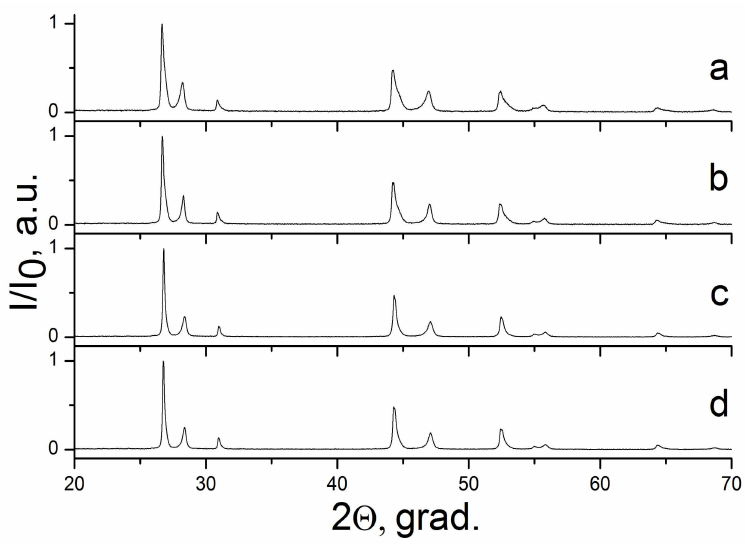
Figure 9. X-ray diffraction patterns of samples in the CaF 2 –SrF 2 (1:1) system synthesized at 300 ◦ C, ratios of M(NO 3 ) 2 :NaF:NaNO 3 (M = Ca + Sr) starting materials: ( a ) 22:33:45 (sample 17); ( b ) 8:12:80 (sample 18); ( c ) 17:50:33 (sample 19); ( d ) 7:21:72 (sample 20).